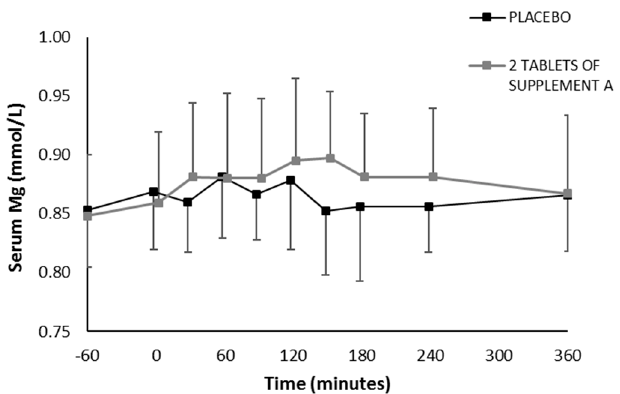
Figure 4. Serum magnesium levels following ingestion of two tablets of Supplement A or placebo. Concentrations were measured 60’ before and immediately before (0’) ingesting the supplements and 30’, 60’, 90’, 120’, 150’, 180’, 4 and 6 h after ingestion.